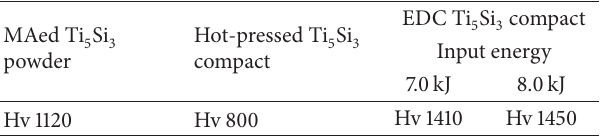
Si compacts. 5 3